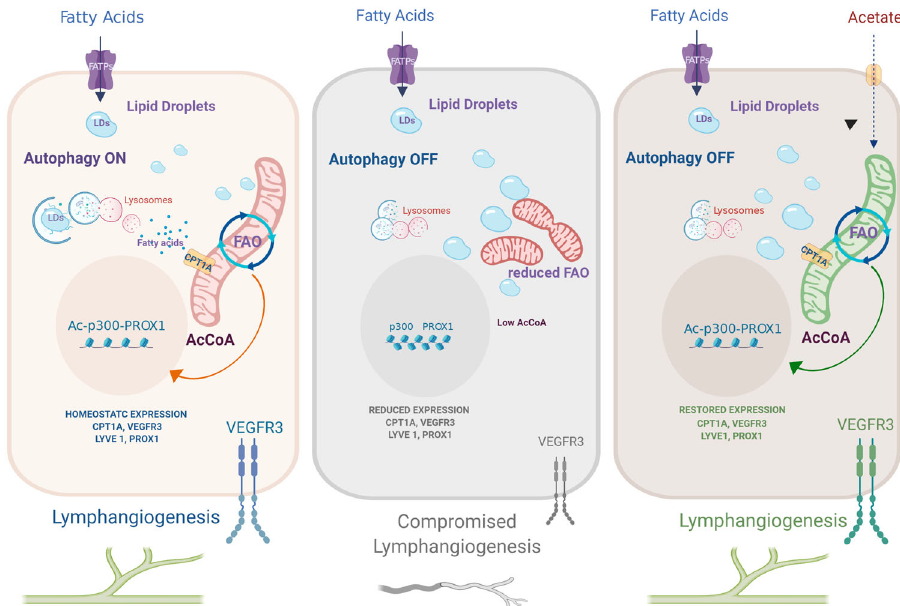
Fig. 8 Lipophagy maintains lymphatic identity and lymphangiogenesis by supplying fatty acids to the mitochondria for fatty acid oxidation and PROX1-mediated gene expression. The fi gure depicts the main phenotypes of (left to right) autophagy-pro fi cient LEC (autophagy ON), autophagy- de fi cient LEC (autophagy OFF), and their rescue with acetate, described in the study. Under homeostatic conditions (left panel), constitutive levels of autophagy favor the turnover of lipid droplets (LDs) in order to supply free fatty acids to the mitochondria and foster fatty acid oxidation (FAO). The actively respiring elongated mitochondria replete acetyl-CoA pools, which is used by the acetyltransferase p300 to acetylate histones at PROX1-target genes. This autophagy-regulated mechanism maintains PROX1-driven expression of lymphatic markers and VEGFR3-mediated lymphangiogenic signaling. When autophagy is compromised (center panel), LDs turnover is impaired causing accumulation of LDS in the cytosol. Under these conditions, the ability of mitochondria to perform FAO is compromised, the mitochondrial network is fragmented and acetyl-CoA levels drop to levels unable to support transcription of PROX1-driven lymphatic gene networks and lymphangiogenesis. This phenotype can be rescued by feeding LEC with the acetyl-CoA precursor acetate (right panel). Acetate rescues mitochondrial morphology and FAO and recovers PROX1-mediated expression of lymphatic genes, thus bypassing the lymphangiogenesis defects caused by genetic loss of autophagy. Image created with anti-DRP1 (1:1000; 611113, BD Biosciences), rabbit anti-H3K4me antibody protease and phosphatase inhibitors (A32953, A32957 respectively, Thermo Fisher (1:1000; ab8580, Abcam), rabbit anti-H3K27 ac (1:1000; 8173T, CST) and rabbit Scienti fi c). Proteins were separated using SDS-PAGE under reducing conditions, anti-FABP4 antibody (1:1000; 2120S, CST). Appropriate secondary antibodies were transferred to a nitrocellulose membrane and examined by immunoblotting. Pri- from Cell Signaling Technology and Thermo Fisher Scienti fi c (Erembodegem, mary antibodies used were rabbit anti-ATG5 (12994S, CST), rabbit anti-ATG7 Belgium). Membranes were scanned using the Bio-Rad Chemidoc Imager (Bio-Rad (1:1000, 8558S, CST), rabbit anti-LC3 (1:1000, 3868S, CST), rabbit anti-GAPDH Laboratories N.V.3). Quanti fi cation of western blot data was done using ImageLab (1:5000, 2118S, CST), rabbit anti-p62 (1:1000, p0067, Millipore), rabbit anti- β -actin software. (1:5000, A5441, Sigma-Aldrich), goat anti-LYVE1 (1:1000, AF2089, R&D systems), rabbit anti-PROX1 (1:1000, 11067-2, Proteintech), rabbit anti-VEGFR3 (1:1000, ab154079, Abcam), mouse anti-NR2F2 (1:1000, ab41859, Abcam), rabbit anti- CPT1 (1:1000, D3B3, CST) antibody, rabbit anti-CPT2 (1:1000, ab18114, Abcam), rabbit anti-acetyl histone H3 (lysine 9) antibody (1:1000, 9671, CST), rabbit anti- pan-acetyl histone H3 antibody (1:1000, 39139, Active Motif)), mouse anti-CD36 antibody (1:1000; ab17044, Abcam), mouse anti-ULK1 antibody (1:1000; ab56344, Abcam), rabbit anti-TOMM20 (1:1000; BD612278, BD Biosciences), mouse anti- OPA1 (1:1000; 612607, BD Biosciences), mouse anti-ENOS (1:1000; 610297, BD biosciences), rabbit anti-phospho DRP1 (Ser616) (1: 1000; 3455S, CST), mouse